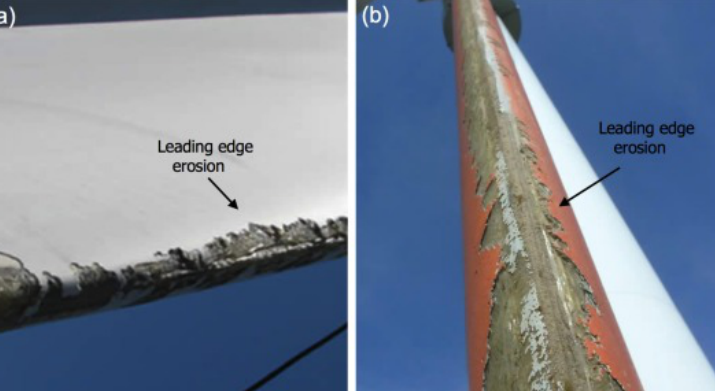
Figure 1. Leading edge erosion damage on two blades ( a ) and ( b ) (reprinted from [11], with permis- sion from Elsevier).